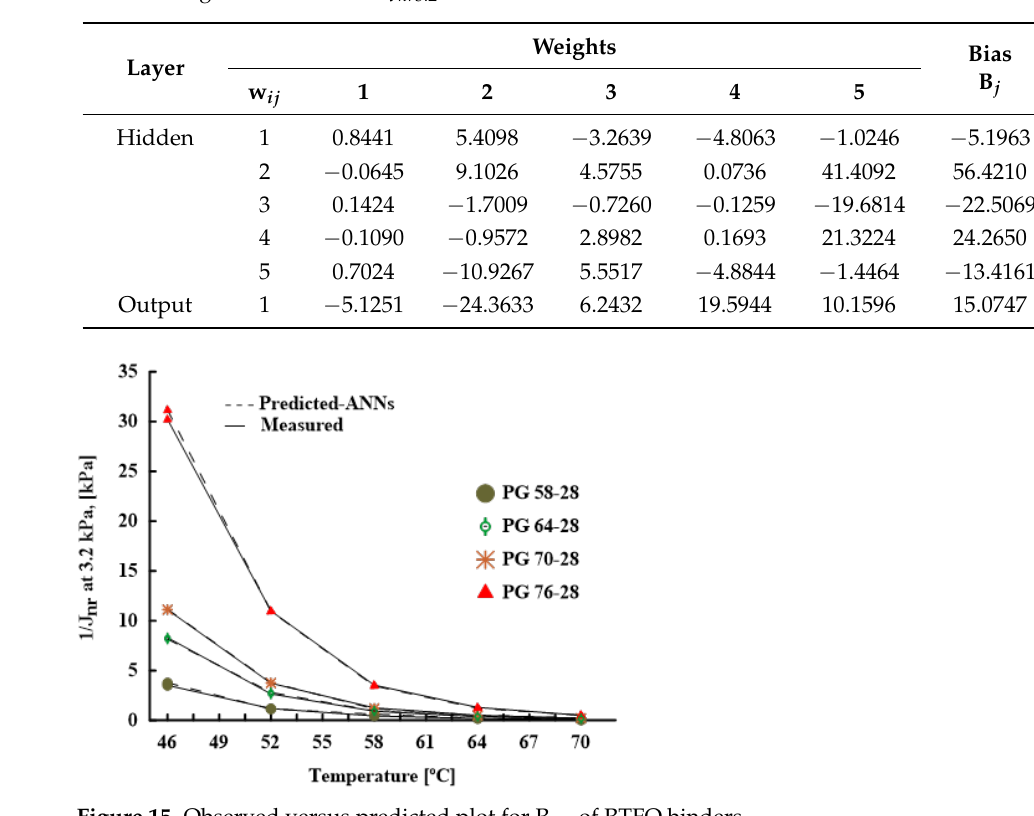
Figure 15. Observed versus predicted plot for R 3.2 of RTFO